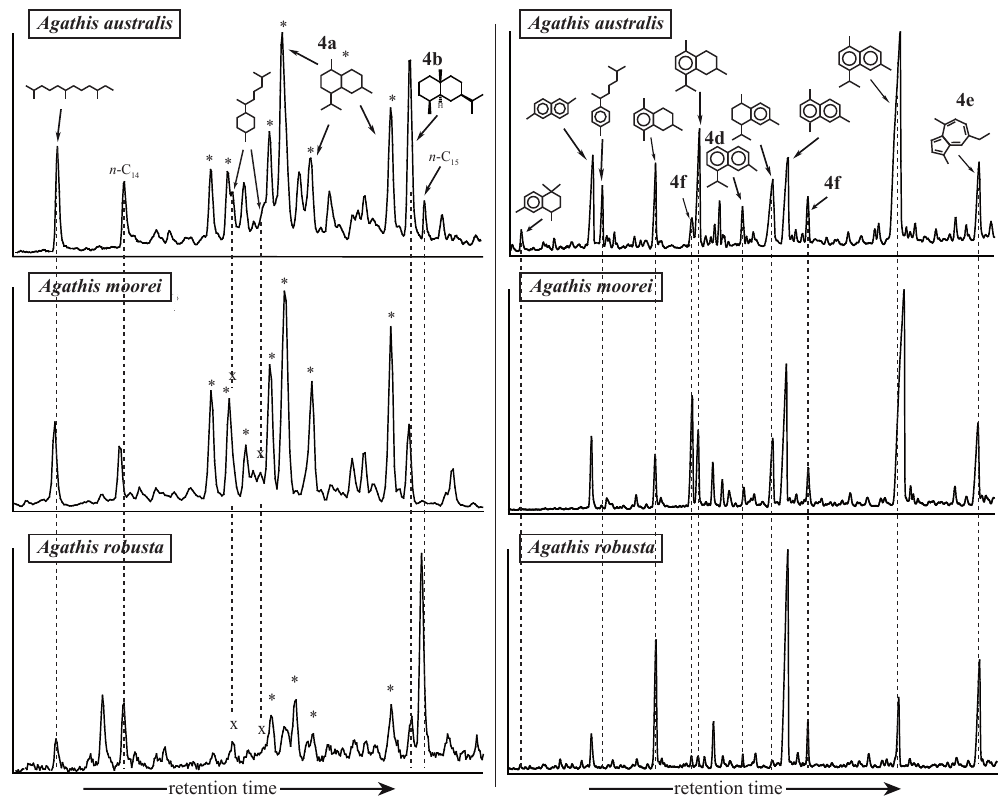
Fig. 10. Partial chromatograms (sesquiterpenoids retention time windows) of aliphatic (left) and aromatic (right) fractions of pyrolysates of Agathis species. The mass spectra of 4a, 4b, 4e, 4f and 4f are given in Fig. 4. x : absence of compound ; ∗ : cadalane-type